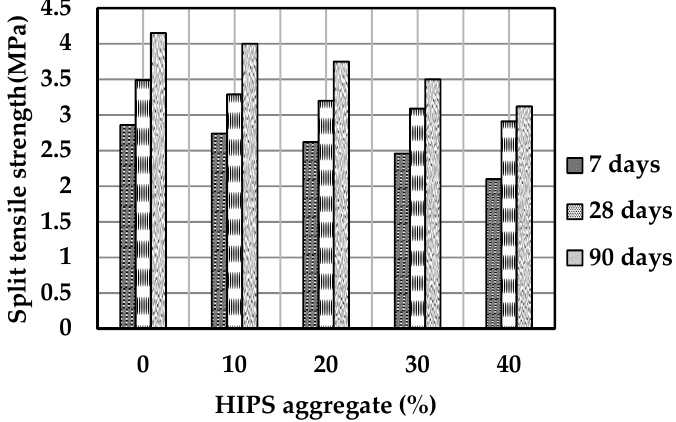
Figure 11. Split tensile strength variation with % HIPS aggregate. 306